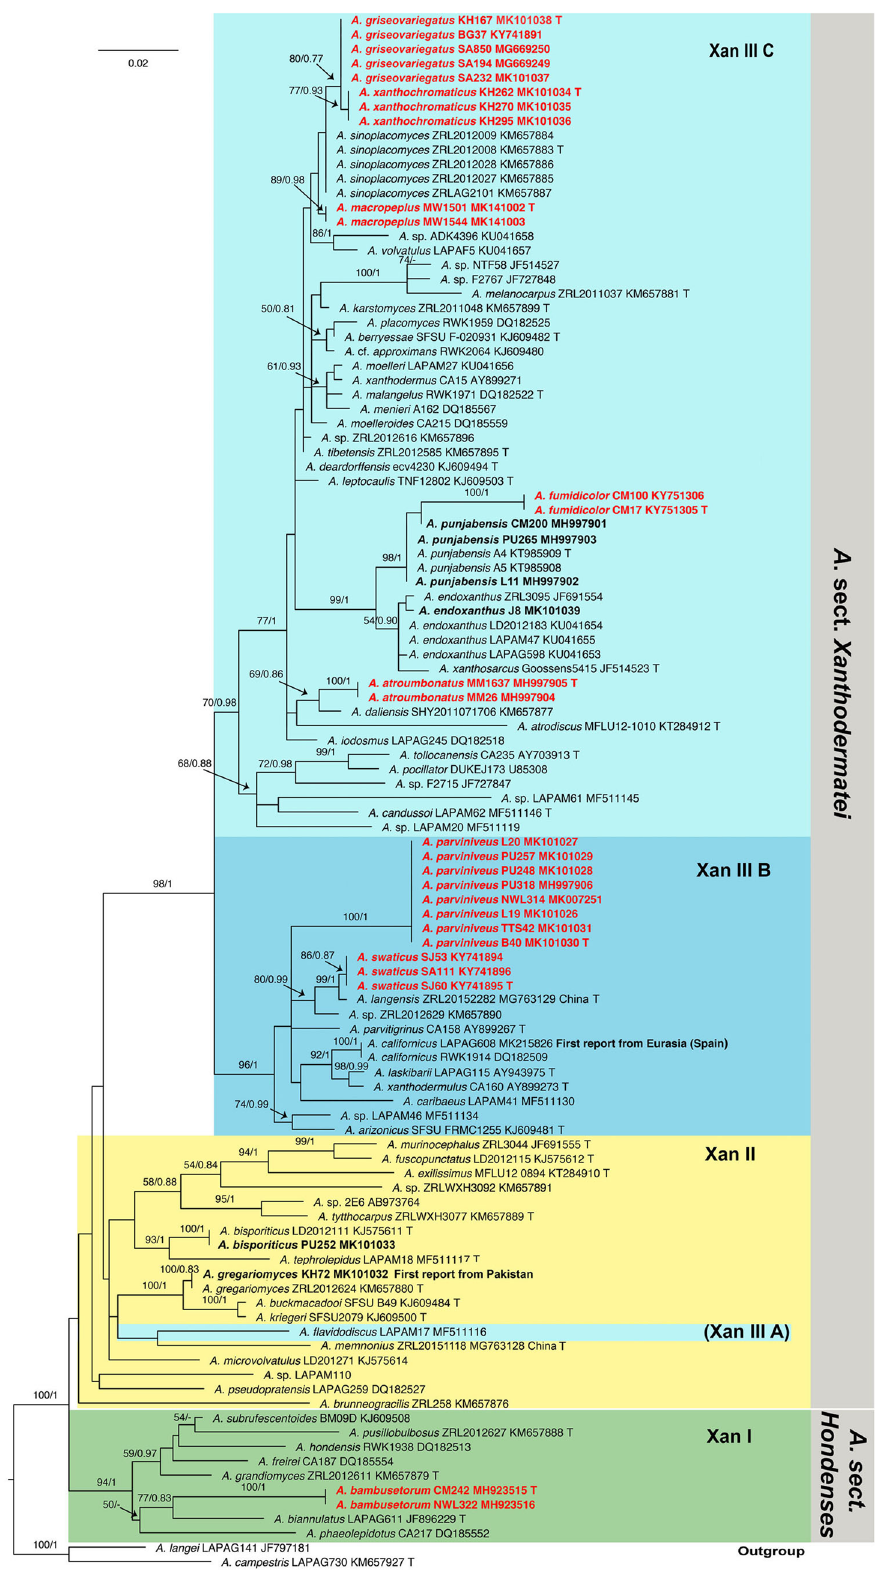
Figure 1. Maximum likelihood tree of species belonging to A . sect. Xanthodermatei and A . sect. Hondenses generated from combined LSU, ITS and TEF1 sequence data. Four species of closely related sections (in A. subg. Pseudochitonia ) and A. campestris (in A. subg. Agaricus ) are used as outgroup. Bootstrap support values and Bayesian posterior probabilities are indicated (BS/PP). New species from Pakistan are in bold red. T type